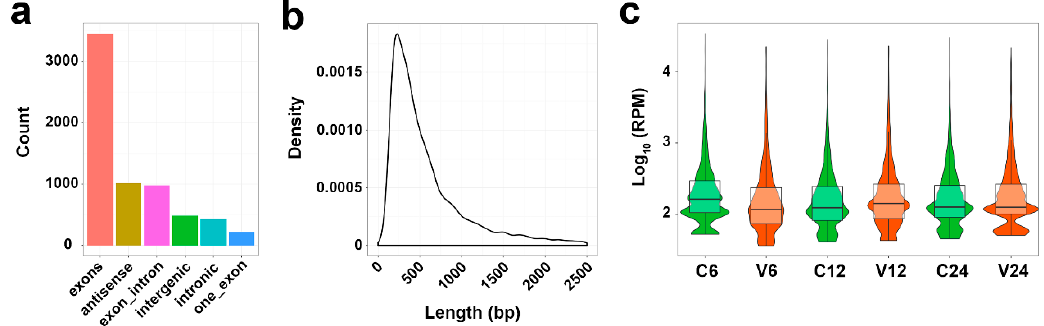
Figure 1. The features of circRNAs in Japanese flounder induced by V. anguillarum . ( a ) Classification of circRNAs. ( b ) The length distribution of circRNAs. bp, base pair. ( c ) The expression profiles of circRNAs in different groups at different time points. RPM, reads per million mapped reads. For convenience, “C6”, “C12”, and “C24” indicate the control groups at 6, 12, and 24 h post-infection (hpi), respectively; “V6”, “V12”, and “V24” indicate the V. anguillarum -infected groups at 6, 12, and 24 hpi, respectively.